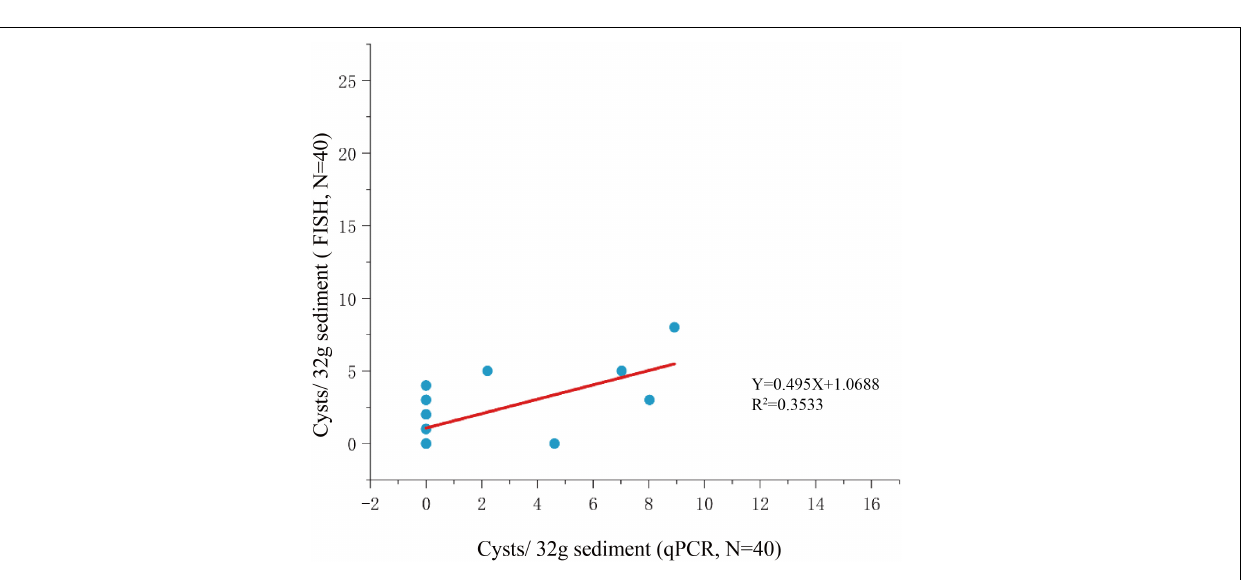
FIGURE 9 | Regression analysis for comparison of qPCR and FISH methods for cyst